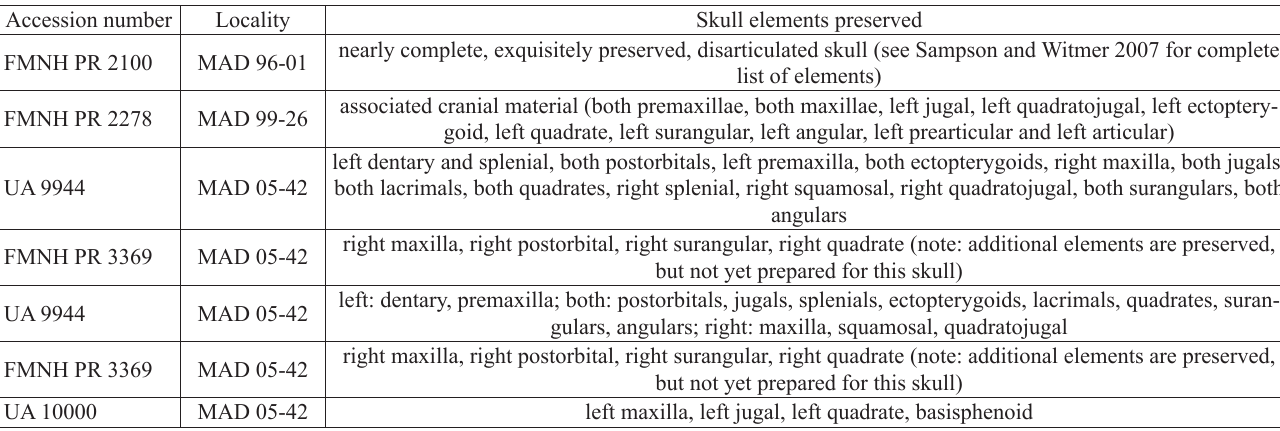
Table 2. List of Majungasaurus crenatissimus skull specimens used in this study (whole skulls). Locality abbreviation: MAD YY-XX, Madagas- car Paleontology Project (formerly Mahajanga Basin Project) locality identifier, with the year of discovery of that locality (YY) and the locality number for that year